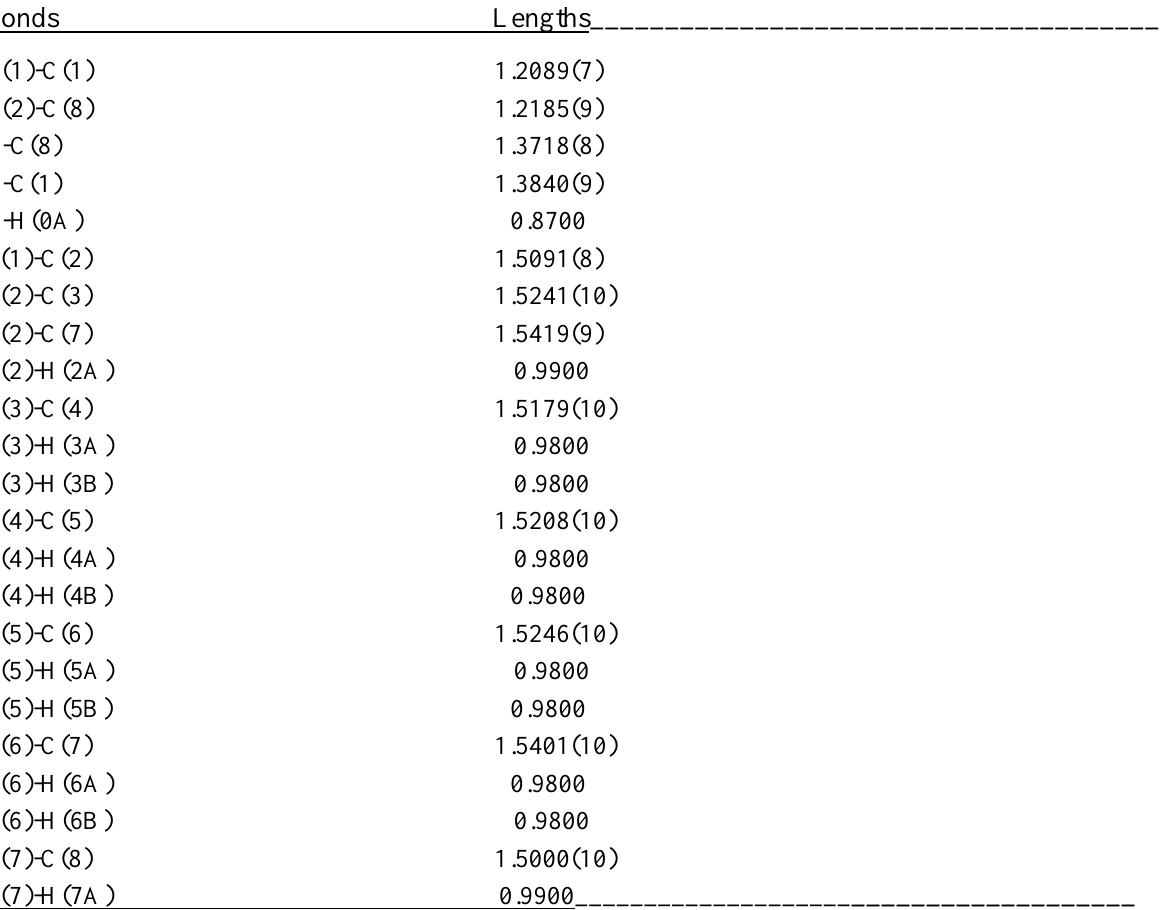
Table 3. Bond lengths [Å] for 3a,4,5,6,7,7a-Hexahydro-1H-isoindole-1,3(2H)-dione.